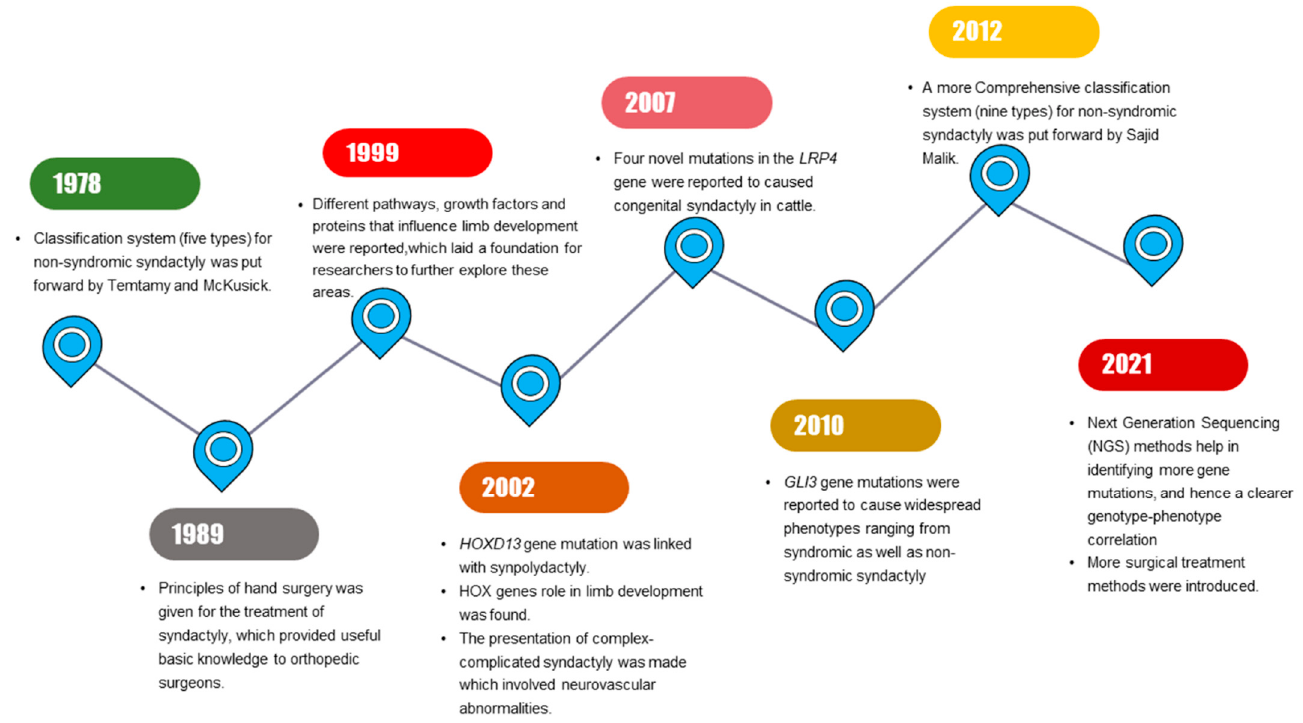
Figure 1. Schematic diagram illustrating the series of milestones achieved in past years in syndactyly research.